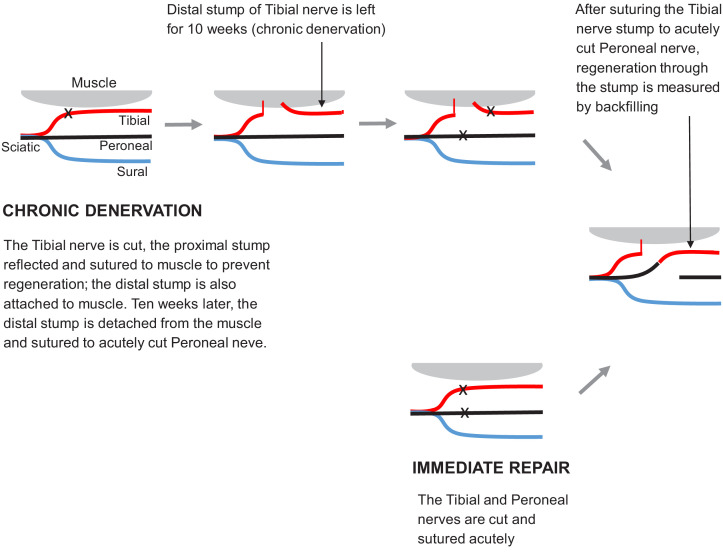
Surgical procedures used to study regeneration after immediate repair and chronic denervation.